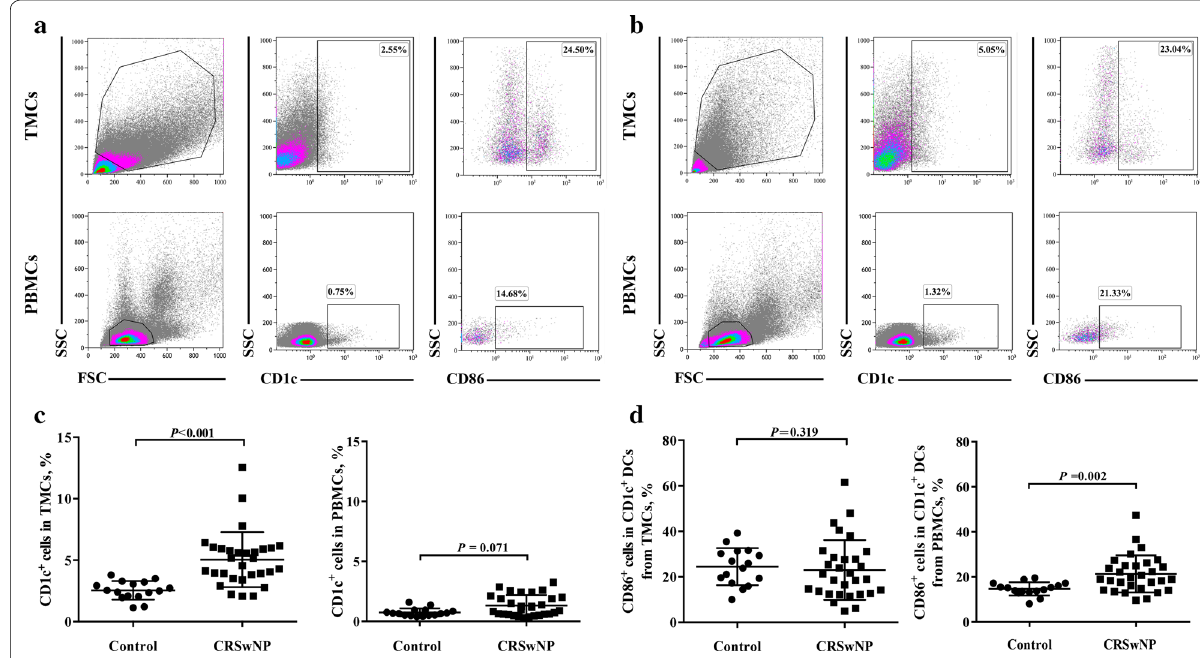
Fig. 2 Percentages of total and activated CD1c + DCs in NP tissues and blood. Representative flow‑cytometry pseudocolor density plots, in which pink‑blue‑green–red indicates increasing cell density, showing the percentages of total CD1c + DCs and CD86 + CD1c + DCs in nasal tissues and blood from healthy controls (n 16) ( a ) and polyp tissues and blood from NP patients (n 30) ( b ). Quantification of the percentages of total CD1c + = = DCs ( c ) and CD86 + CD1c + DCs ( d ) in NP tissue and blood. Data are presented as mean with SD or median with